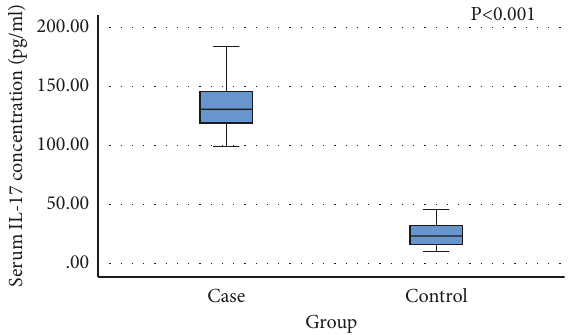
Figure 1: Serum level of IL-17 in the study COVID-19 patients ( n � 132) and healthy controls ( n � 135). P < 0 .